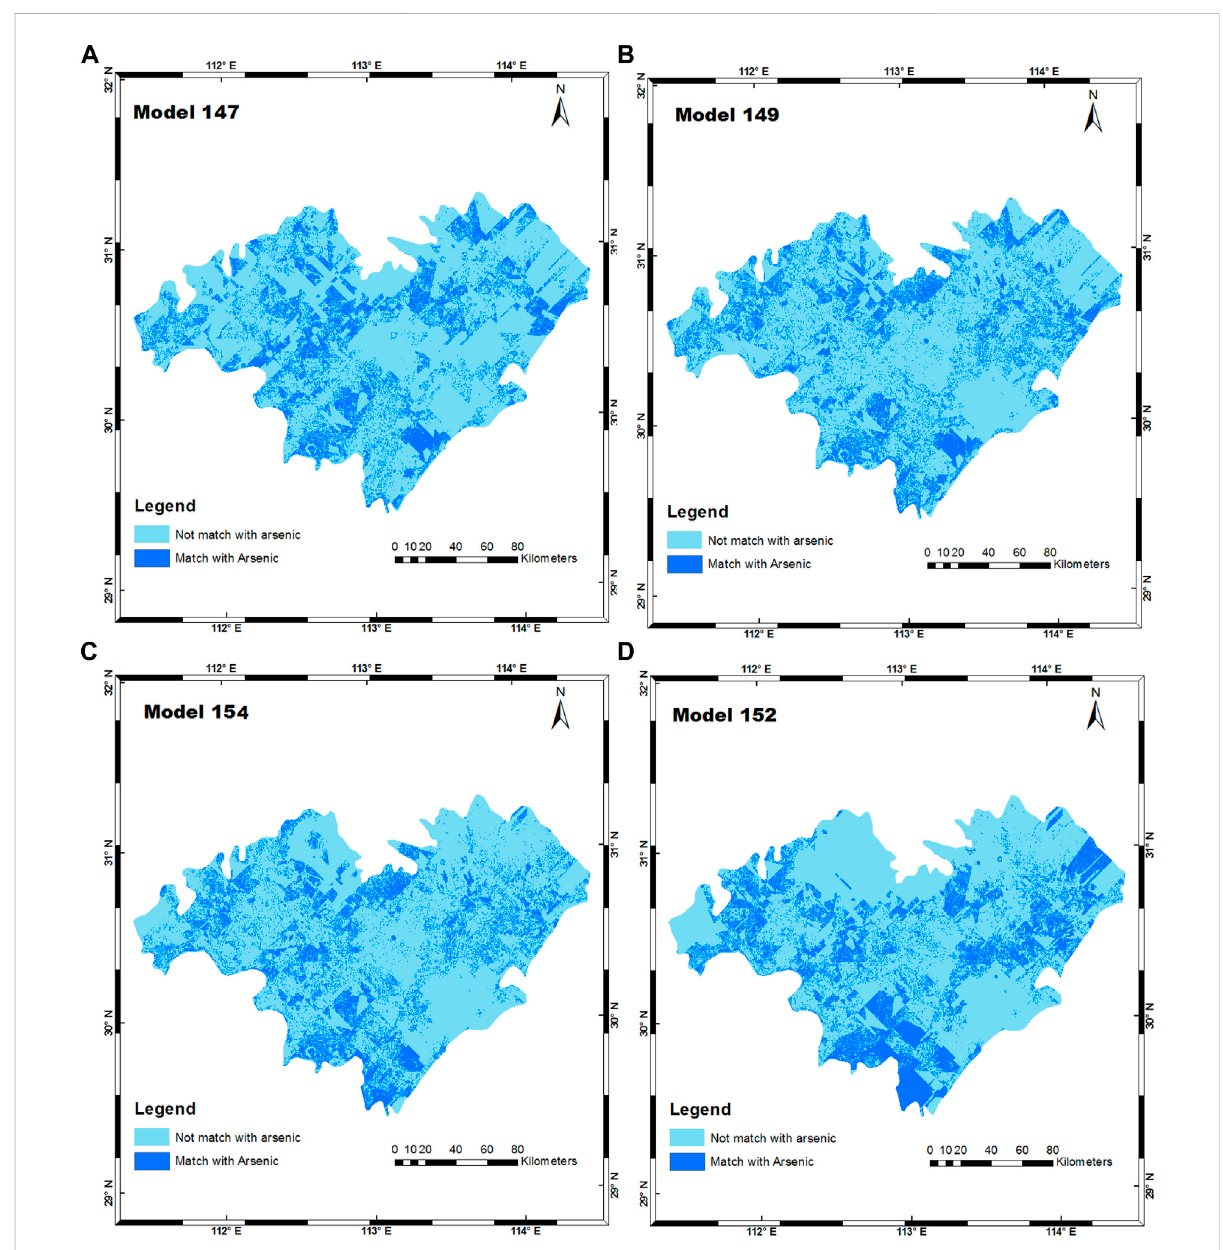
FIGURE 5 The best matching frequencies maps models for soil arsenic concentration among the multifactor models were observed for Soil*(1Pump+3LU+2Cont) in panel (A) , soil*(1LU+2Cont) in panel (B) , soil*Pump in panel (C) and soil*LU in panel (D) with an equal frequency